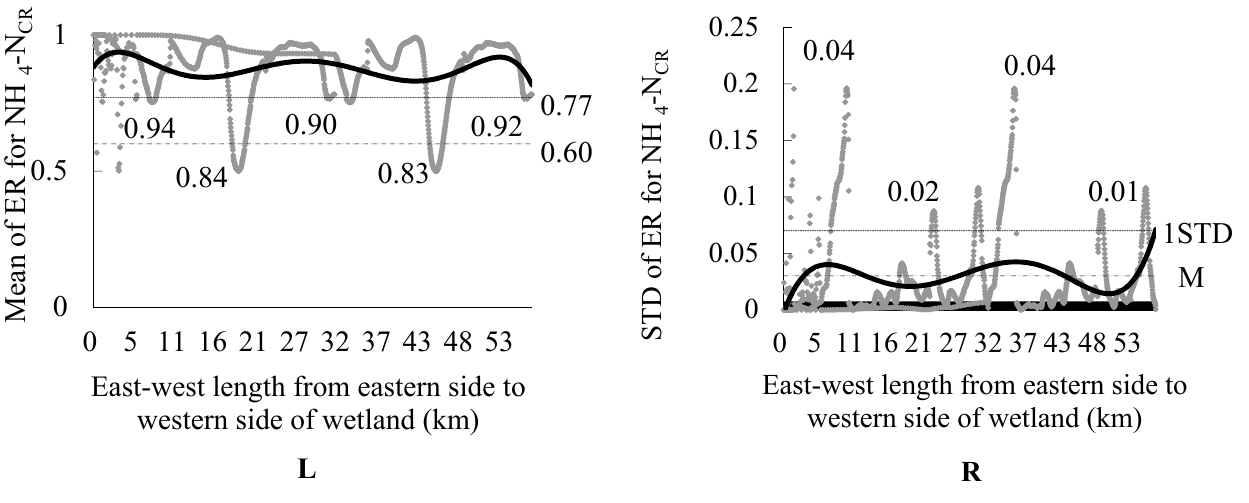
Figure 6. Mean and STD functions of the ERs between TN CR and NH 4 -N CR (dependent index) and the distance of the water inlet (independent index) during the gradual buffer extrapolation, based on the water inlet as a start line in the Sanhuanpao wetland. The curve on the left ( L ) is the mean of the ERs between TN CR and NH 4 -N CR , the curve on the right ( R ) is the STD of the ERs between TN CR and NH 4 -N CR , and the numbers in the figure are the maximum and minimum values of the fitting functions.